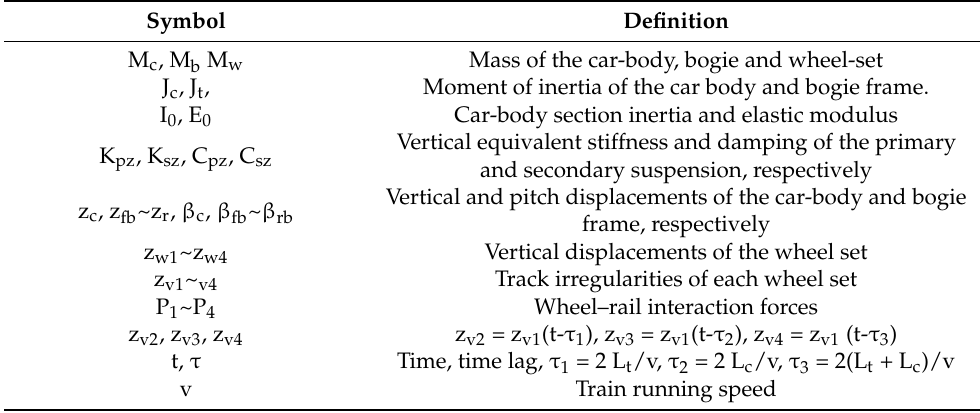
Table A1. Definitions of the symbol used in Equations